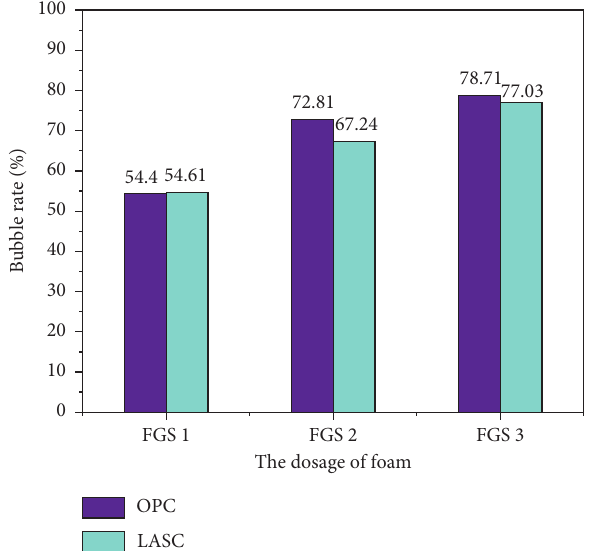
Figure 11: Foam dosage and bubble rate of the filling material.